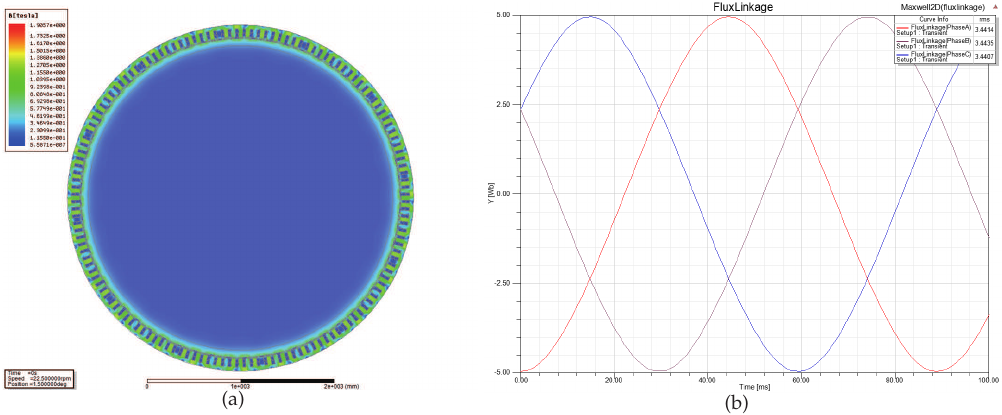
Figure 9. Results of finite element analysis with ψ f ≈ 3.44 Wb in Case 1 : ( a ) Nephogram of magnetic flux density; ( b ) Corresponding waveform of magnetic flux linkage.